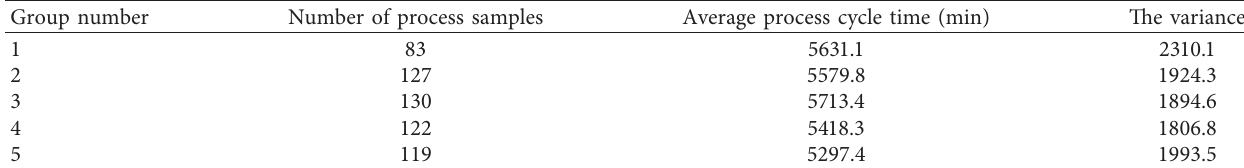
Table 8: Simulation results of freight flow before reconstruction.